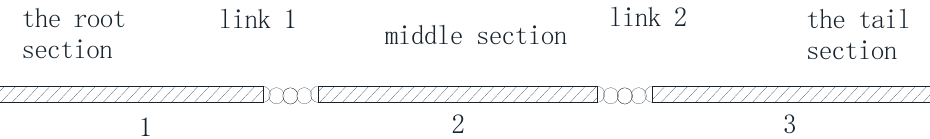
Figure 1. Schematic diagram of three-section cudgel model. (1,2,3 refers to the sequence arranges from where cudgel is held to hit).